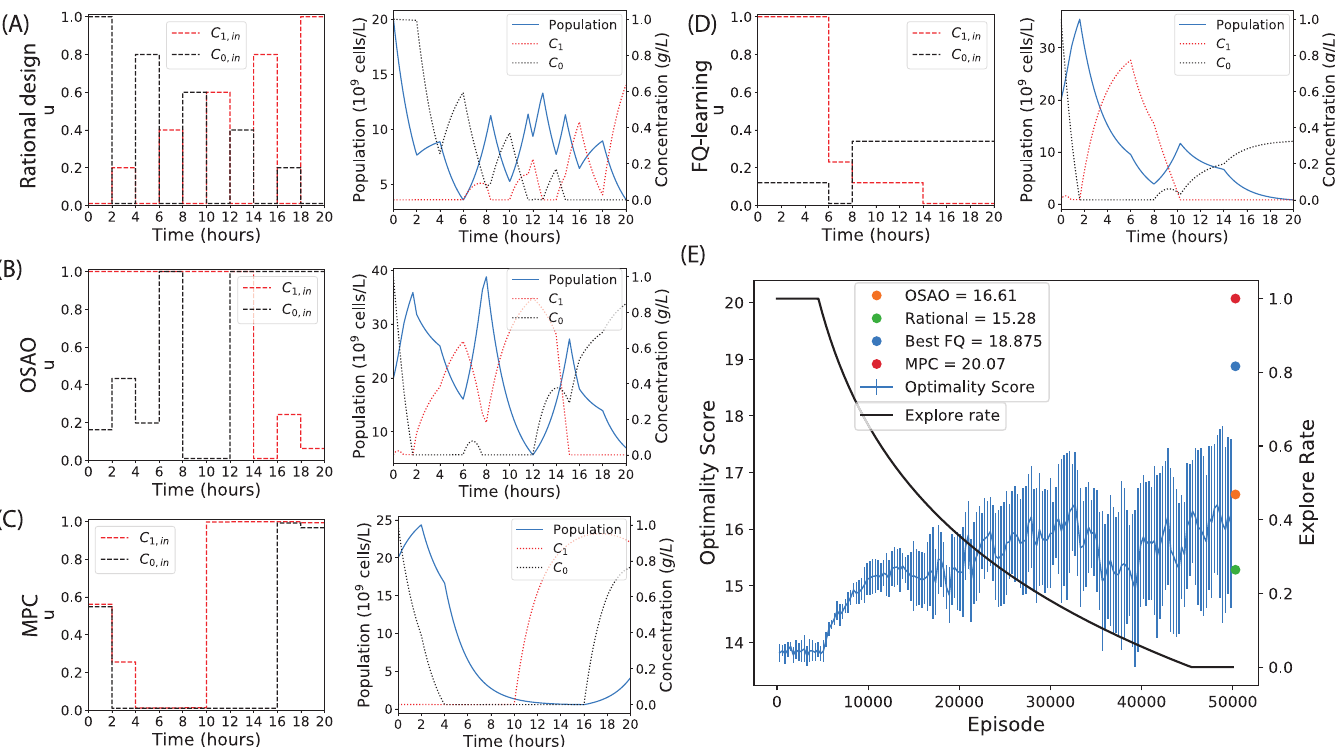
Fig 2. Optimal experimental design to infer the values of model parameters for an auxotrophic bacterial strain growing in a chemostat. Control inputs chosen by (A) rational design, (B) one step ahead optimisation, (C) model predictive control, and (D) FQ-learning, along with the corresponding system trajectories. (E) Training progress of ten independent FQ-agents over 50000 episodes, their shared explore rate, and (far-right) the scores of the MPC, OSAO and rational design. The mean FQ- agent return is shown, along with error bars indicating one standard deviation.